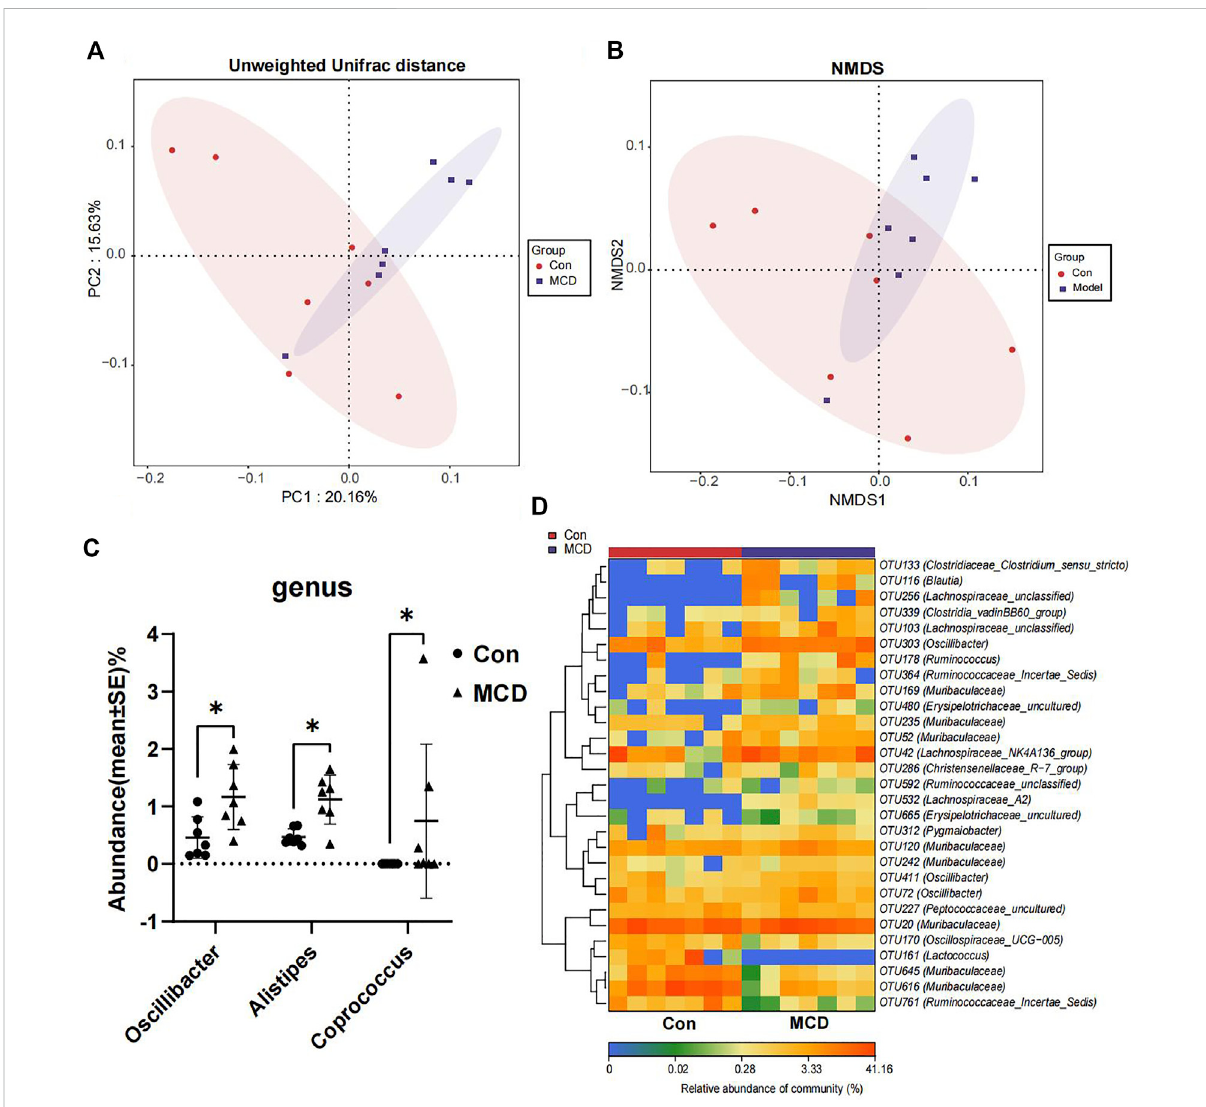
FIGURE 7 ComparisonofgutmicrobiotacompositionofratsinCongroup( n =7)andMCDgroup( n =7). (A) PCoAdiagramshowedtheweightedUniFrac distance had obviously difference betweenCon group and MCD group. (B) NMDS diagram showed the difference in composition of gut microbiota. (C) There genera of bacteria changed markedly in MCD group. (D) Heatmap showed difference in relative abundance of key